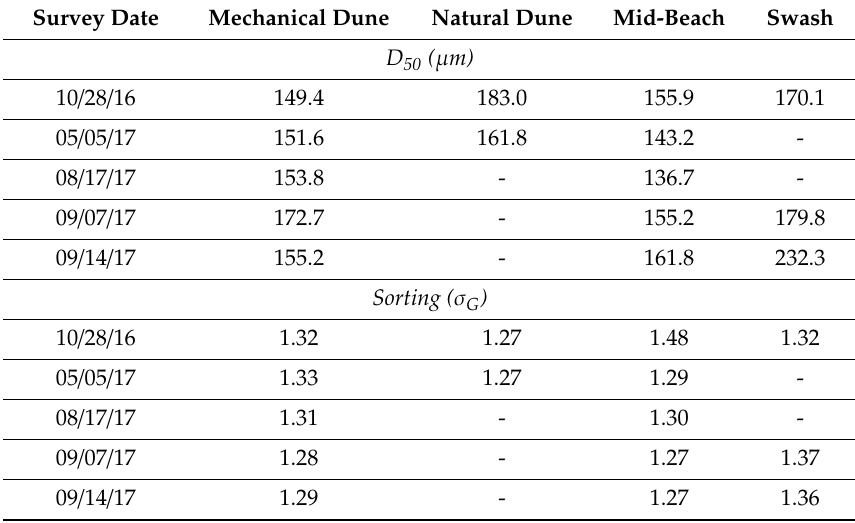
Table 1. Grain size characteristics (median (D 50 ) and sorting ( σ G )) for the mechanical and natural dune, the mid-beach, and swash zone. Empty cells indicate that no sand samples were collected at that time and location.